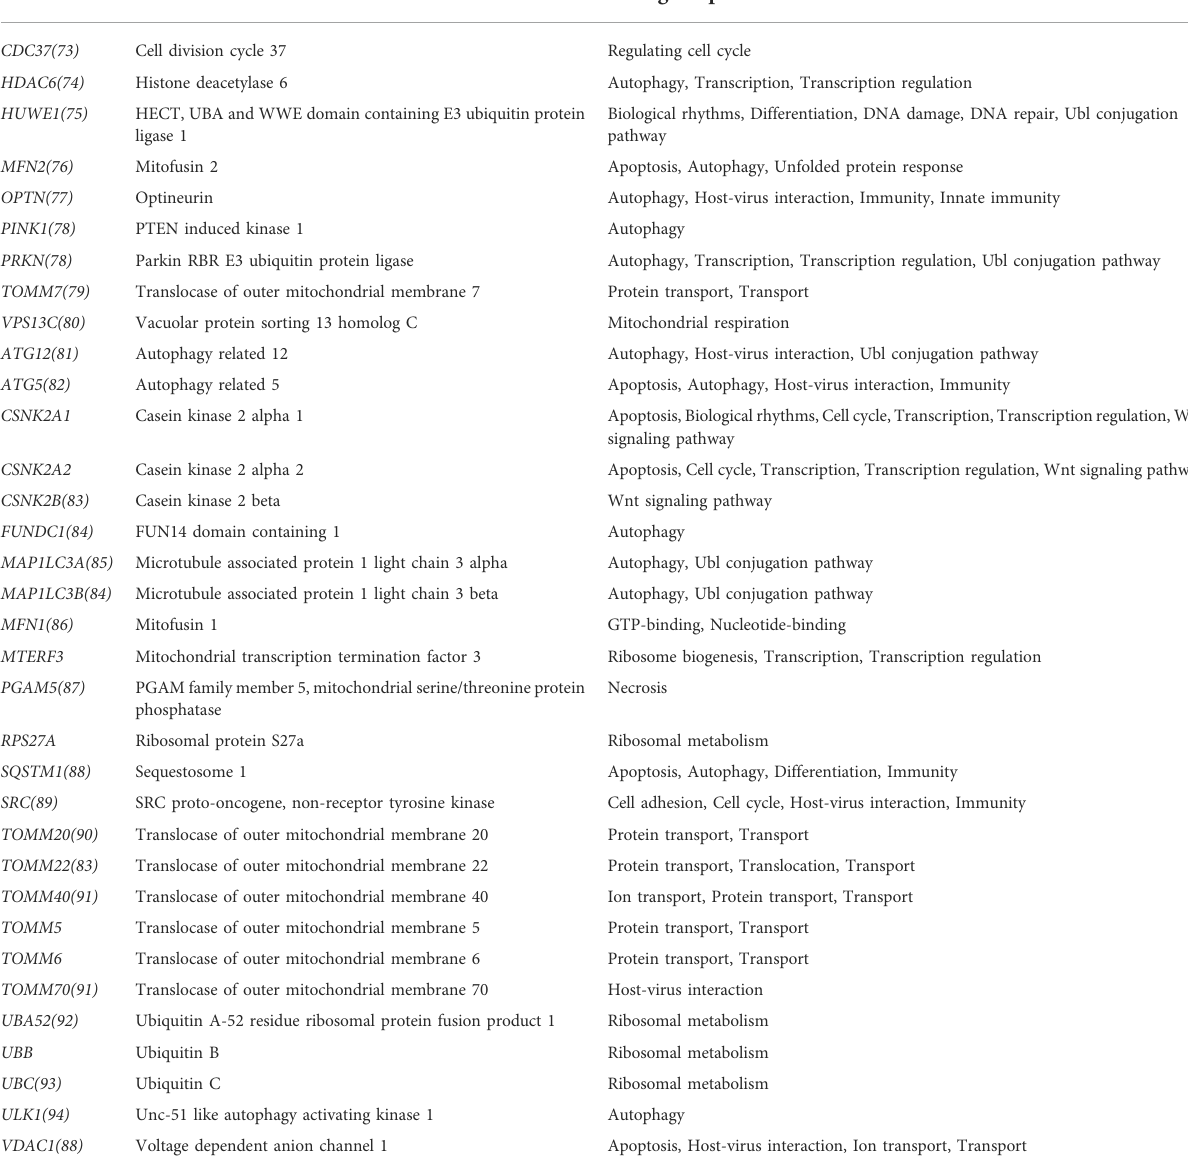
TABLE.1 All mitophagy-related genes and the biological functions of their encoded